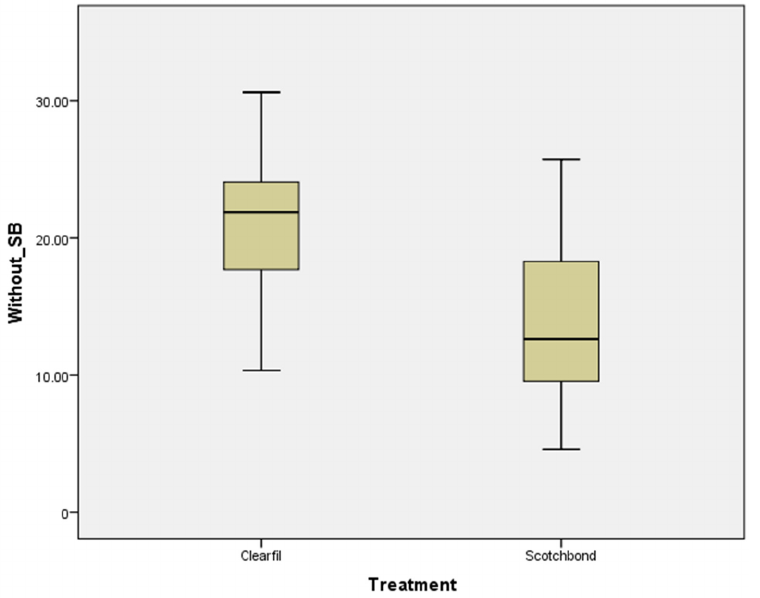
Figure 3. Shear bond strength (MPa) for Clearfil SE and Scotchbond Multi-Purpose with air abrasion.